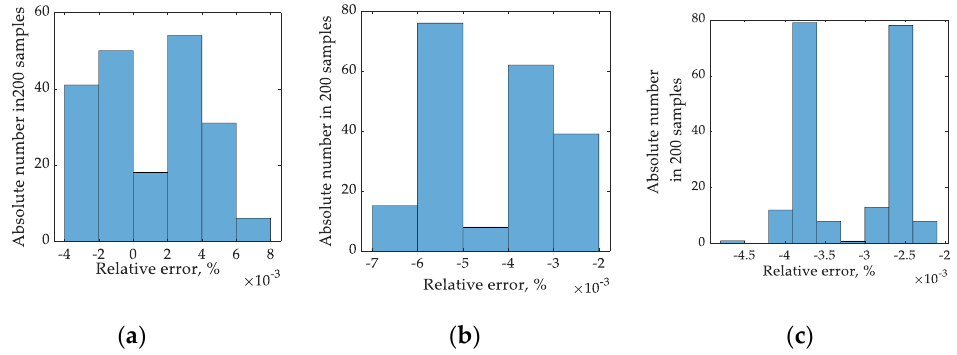
Figure 7. Histograms of a relative RMS error for one-harmonic estimation with sampling time of 5 ms ( a ), 7 ms ( b ), and 9 ms ( c ).